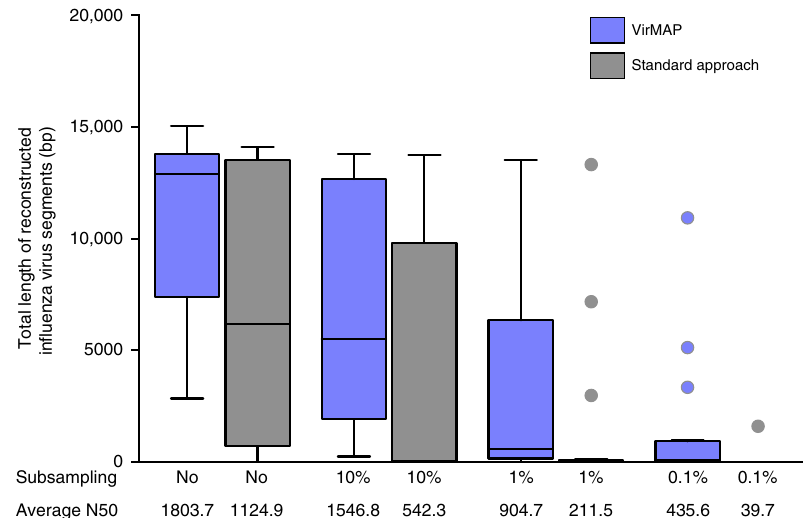
Fig. 4 A comparison of VirMAP and the Standard Approach using the in fl uenza virus dataset (BioProject ID PRJEB7888). The total length of reconstructed in fl uenza virus segments was calculated at different levels of subsampling by adding the total number of base pairs found for across segments. An average N50 was calculated at each subsampling level by averaging the N50 values for all trials (20 at 100%, 200 at 10, 1, and 0.1). The percentage of positive trials correspond to the ratio of trials with >1 identi fi able in fl uenza contig over the total number of trials (20 at 100%, 200 at 10, 1, and 0.1%). Tukey plots, bar: statistical median, edges: low, 25%; high 75% quartiles, whiskers:1.5 × interquartile range, dots: